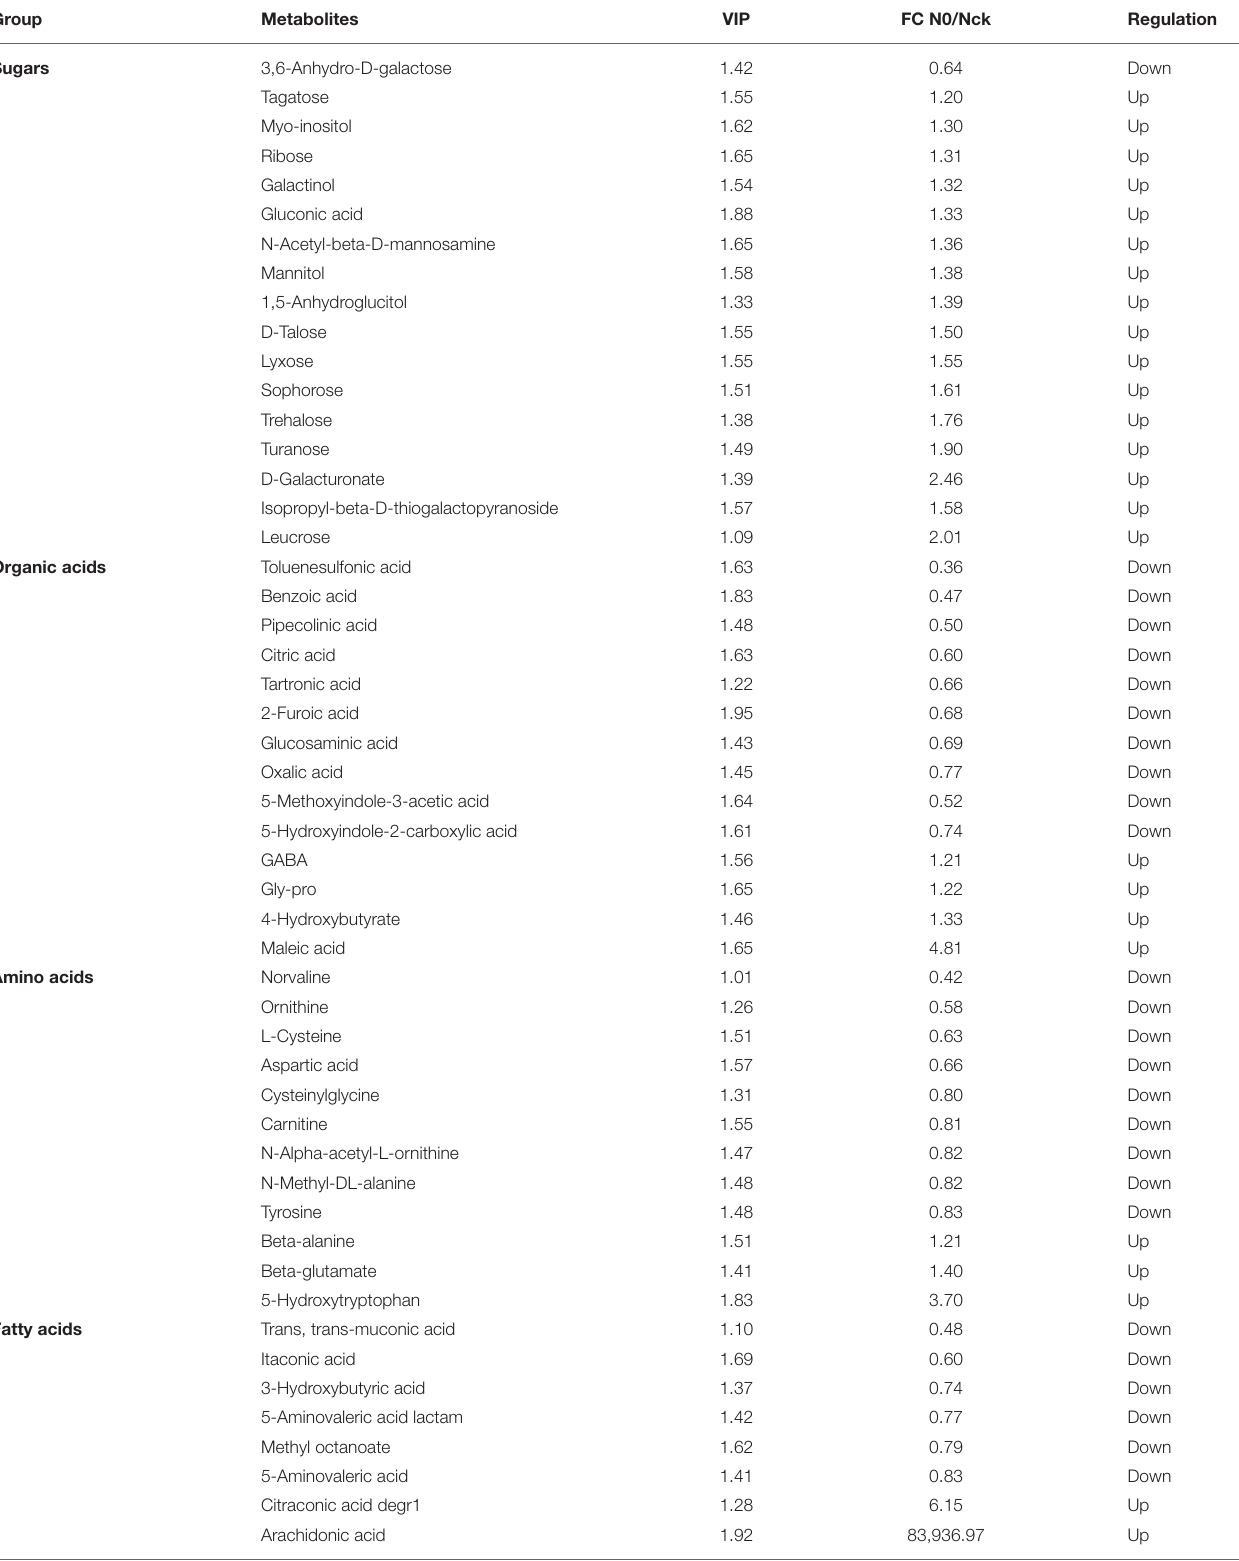
TABLE 3 | Seventy-seven metabolites identified in wheat grain with N0 and Nck treatments.